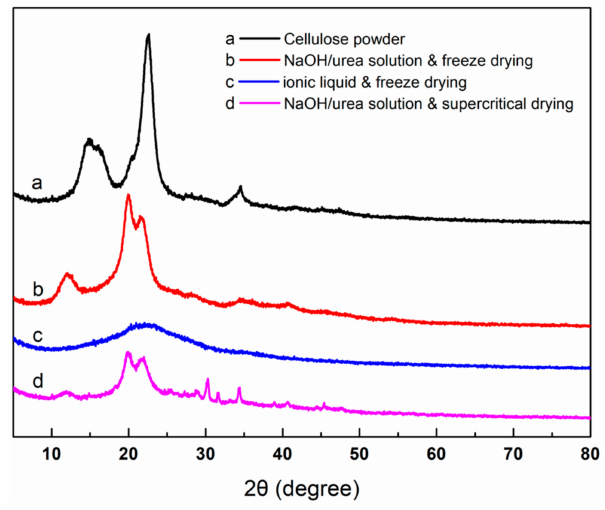
Figure 5. X-ray diffraction patterns of raw cellulose powder and cellulose aerogels prepared under different conditions. Table 1. Peak positions in X-ray diffraction of cellulose polymorphs [29].